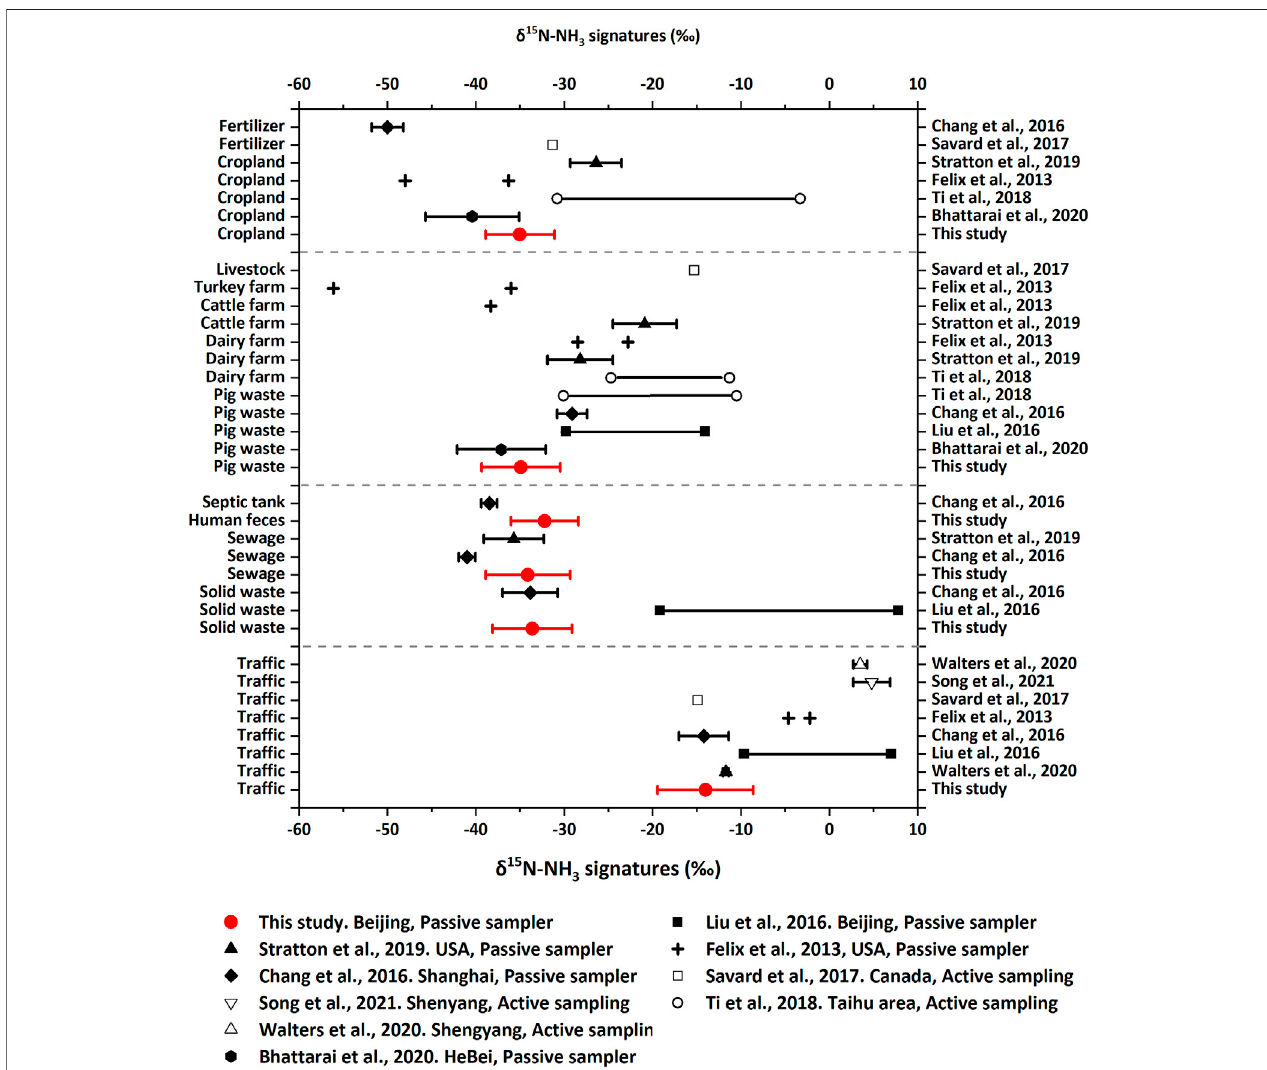
FIGURE 3 | Comparison of δ 15 N values for major NH 3 emission sources in this study to other studies.